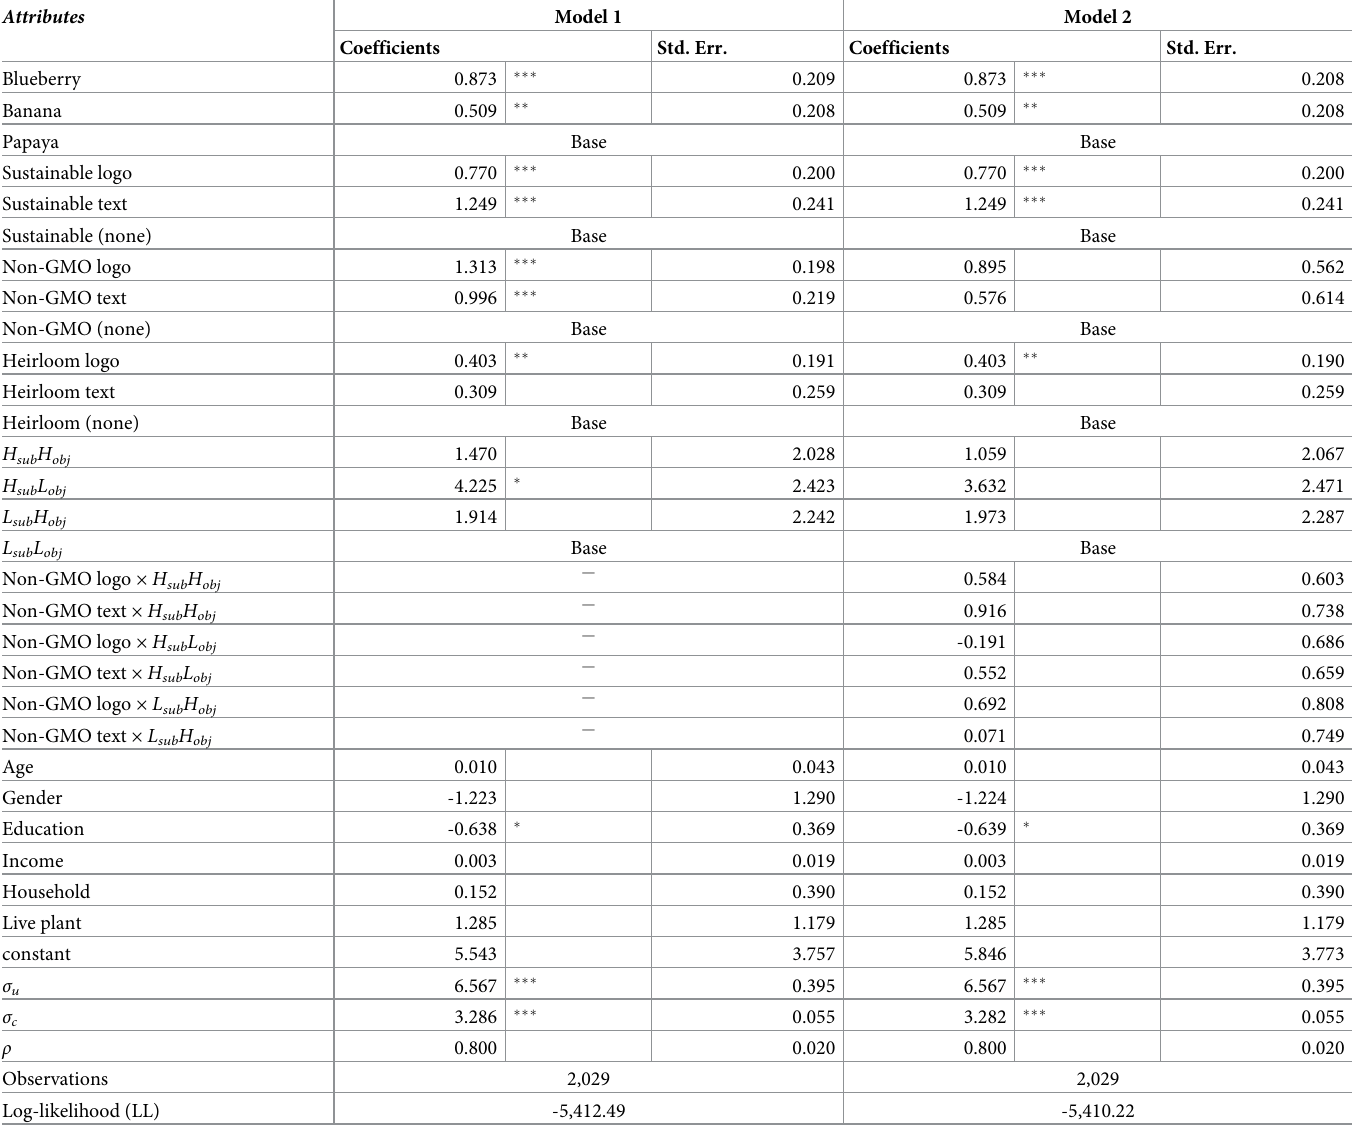
Table 5. Random effects tobit model estimates from an experimental auction (n =